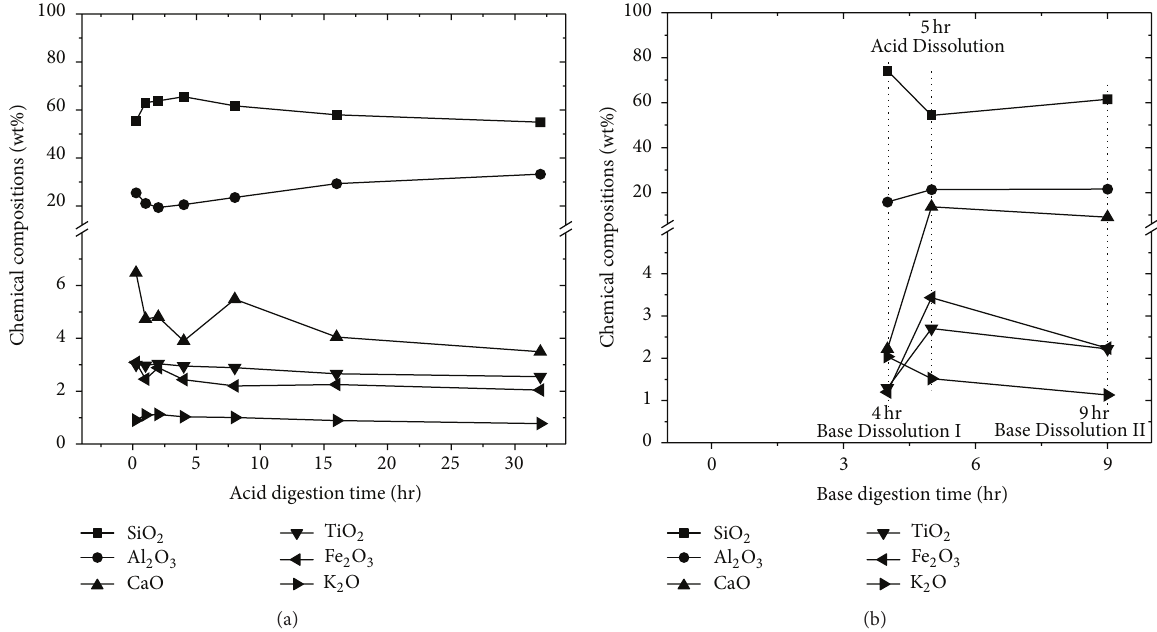
Figure 9: Chemical composition changes of dissolved components of ARFA in acid digestion process (a) as a function of time and base digestion process (b) as a function of